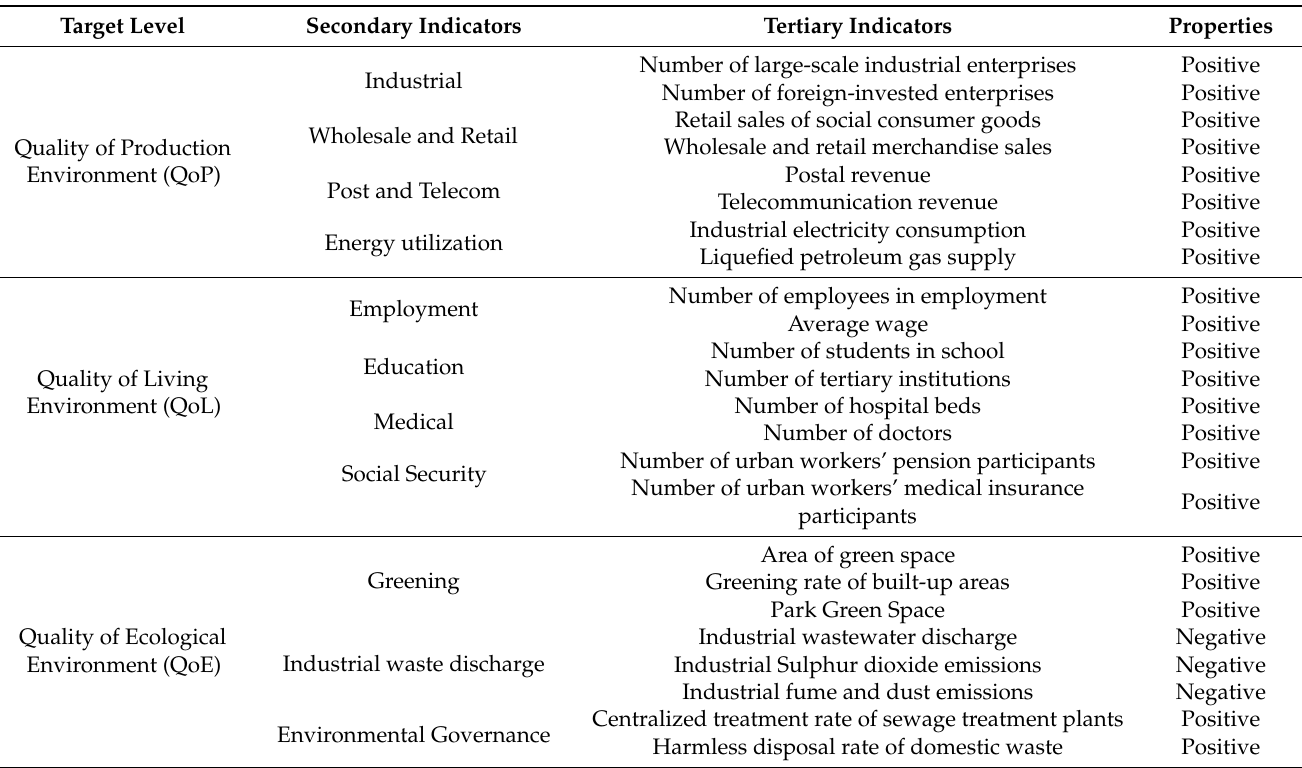
Table 1. Indicator system for evaluating the environmental quality of “production, living and ecology” in